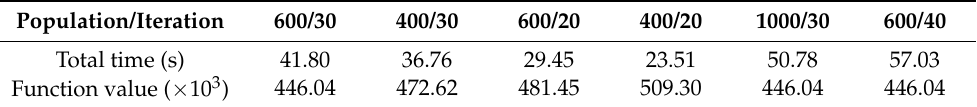
Table 5. Comparison of BPSO results under different settings in Scenario II.